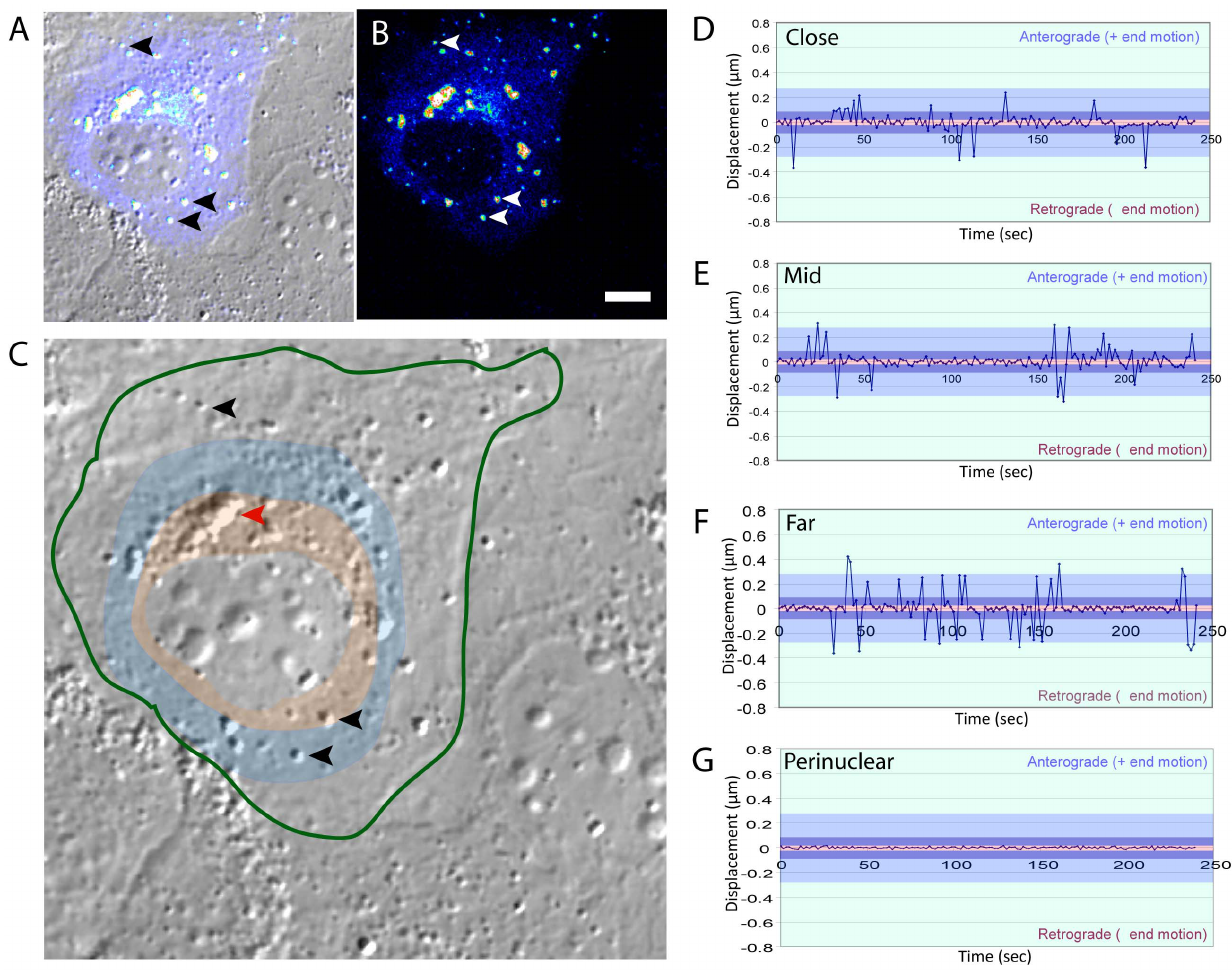
Figure 5. Tracking LD mobility at distinct locations of the cell. While all of the mutants were tracked accordingly, Huh-7 cells expressing DII- core G161A is a representative image acquired from a large data set. Huh-7 cells expressing DII-core G161A is shown as (A) a merged image of DIC and TPF, and (B) TPF. DII-core G161A coated LDs are selected, and indicated by the arrows, to demonstrate fluorescence overlap between TPF and DIC. (C) LDs localized at different areas within the transfected cell (green outline) were segregated into regions relative to the center of the nucleus, such as close (orange shading), mid (blue), and far (no shading). Each black arrow represents a DII-core G161A coated LD for each of the segregated region, and the velocities were measured for each direction in the close (D), mid (E), far (F) regions. The red arrow selects for a region of dense LDs in the perinuclear region with higher levels of DII-core G161A . (G) The velocity of the LD, identified by the red arrow was measured. All scale bars represent 10 m